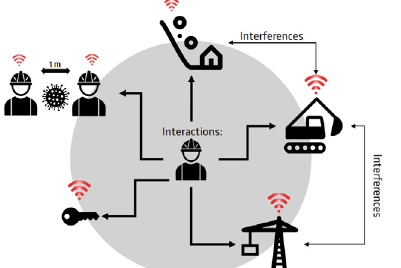
Figure 10: Interaction among sensors. The diagram represents how the worker is protected by the sensors through the interaction with the different dangers.